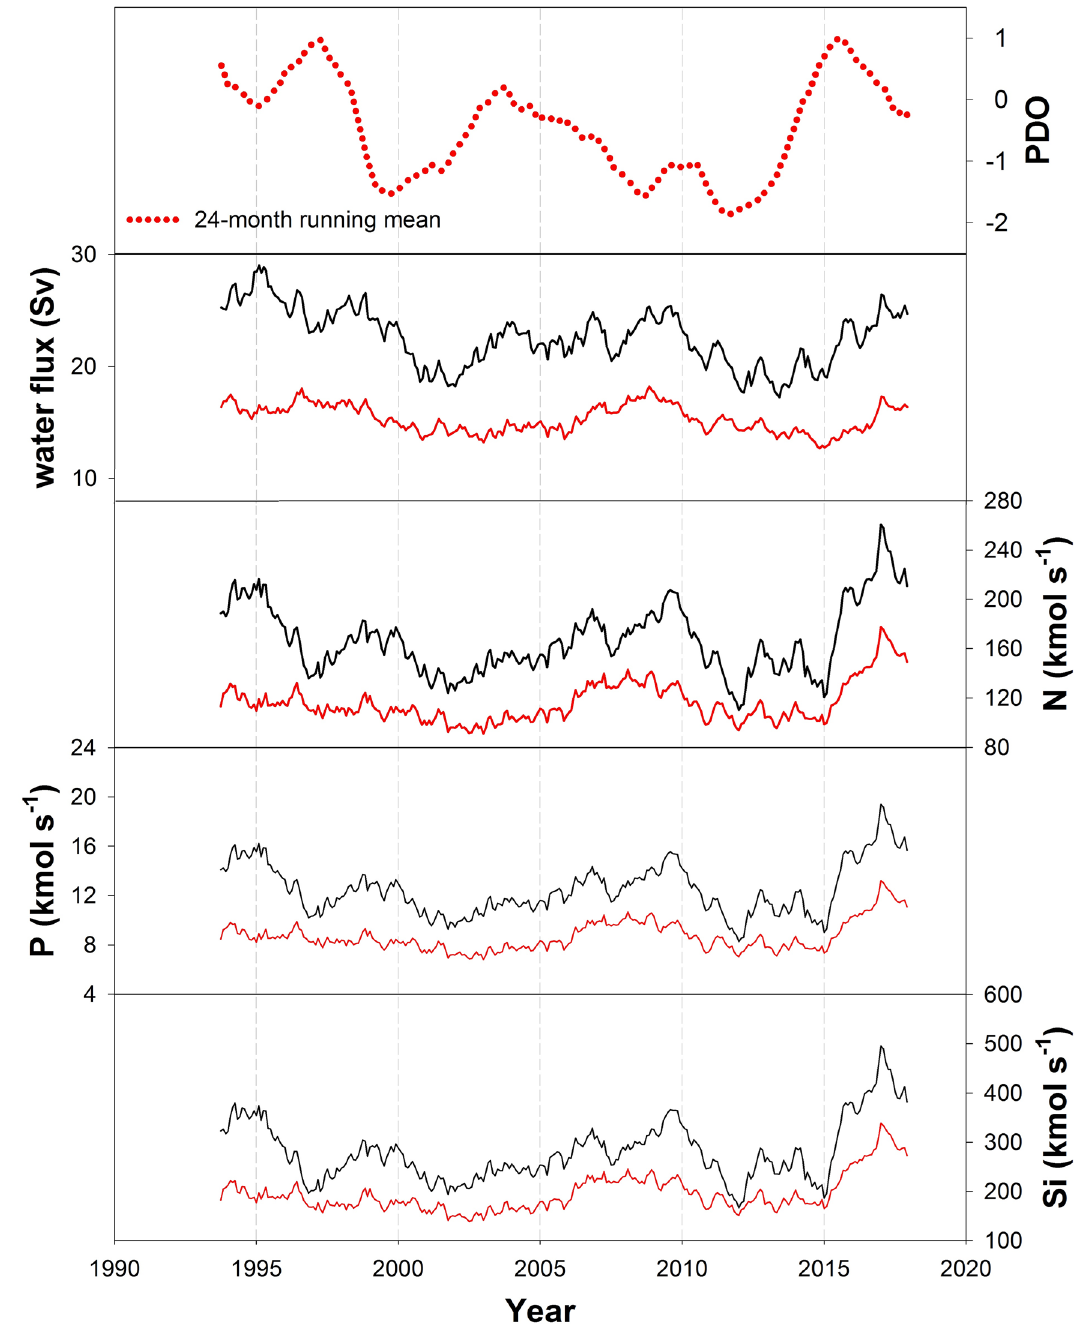
Figure 3. Interannual variation of the PDO index (24 month-moving-average), water, N, P, and Si transports (0–1000 m) between 121–123° E (black lines) and between 121–122° E (red further to the left. In the ECS, another intense shoreward upwelling occurs, and the subsurface waters further upwell by 300 m within a degree in latitude (Fig. S5). Based on the nutrient budgets of Chen and Wang 24 , only 4, 4 and 8% of the N, P, and Si, respectively, that are transported by the Kuroshio nutrient stream between 121 and 122° E are used on the ECS shelf, while the rest is transported farther to the north and northeast. Four reports on the Kuroshio nutrient stream along the Kuroshio path (Fig. 1) have been published. Close to the Kuroshio’s origin is the PR 20 line (N, P, and Si; Chen et al. 1 and this study), followed by the KTV1 line east of Taiwan 4 (N only). Further downstream is the PN line in the East China Sea 2,3 (N and P), and finally at three cross-sections south of Japan 2 (TK, ASUKA, and 137° E lines; N only). The water transport at the PR 20 line (121–123° E) herein agrees with all other relevant studies within uncer- tainties (Fig. 4a) but is more than 50% less than that in the Gulf Stream 5,27 (25 ~ 27° N). The nutrient transports herein also agree with reported values for the Kuroshio region, except for the very high N transport across the